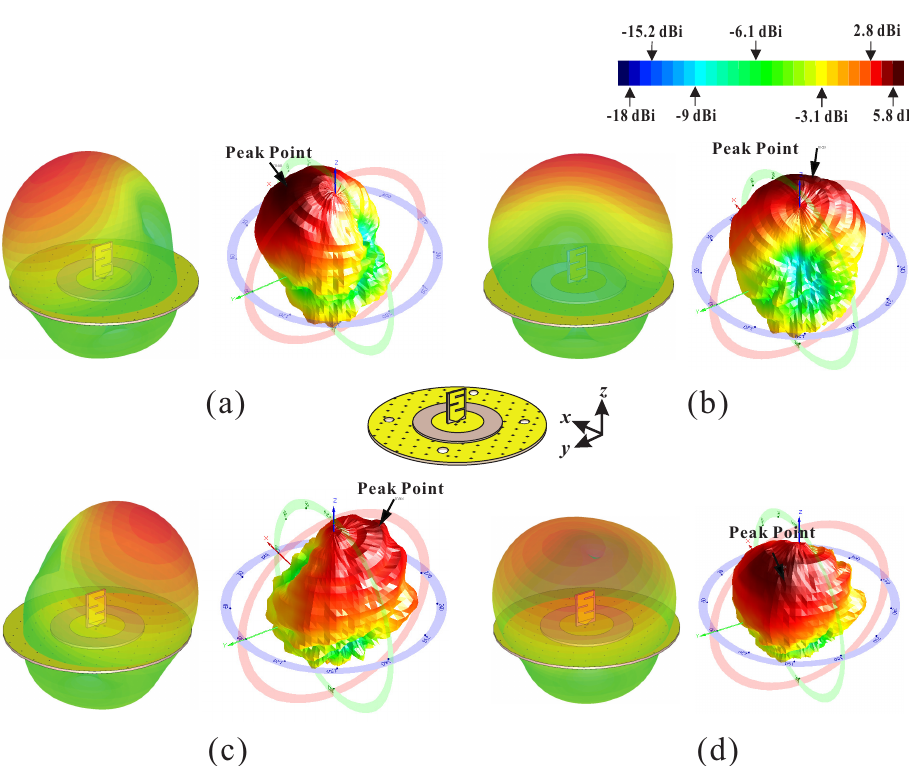
Figure 6. Comparison of simulated and measured 3D radiation pattern results for each mode: ( a ) Mode 1, ( b ) Mode 2, ( c ) Mode 3, and ( d ) Mode 4.